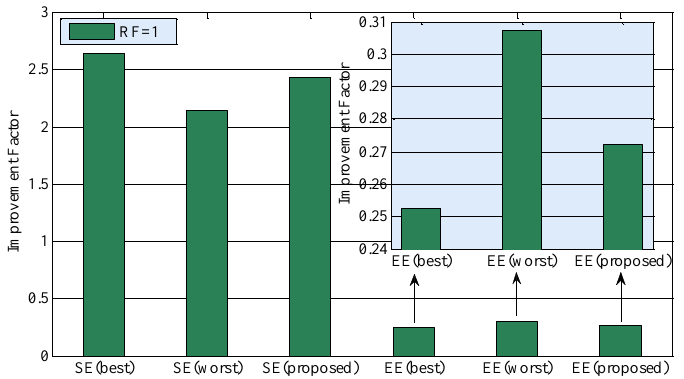
Figure 3. Performance of the proposed technique over the traditional SLSA technique due to the variation in co-channel interference (CCI) experienced by each SBS of MNO 1 located in an apartment of a building for RF = 1 in terms of SE and EE. The best case refers to no CCI, and the worst-case refers to the maximum CCI.